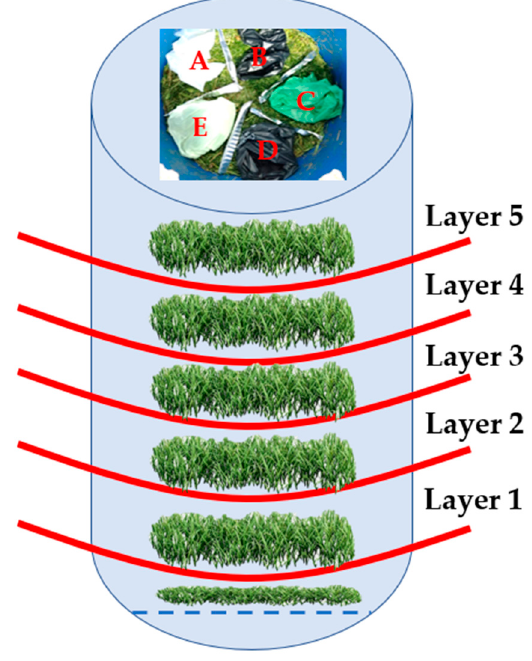
Figure 1. The arrangement of the investigated DPBs (A–E) in the composting reactors R1 and